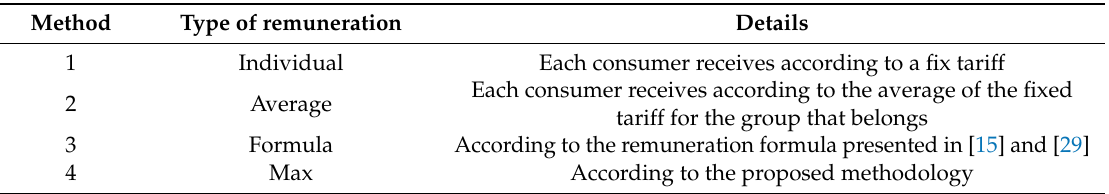
Table 8. Methods for Remuneration Comparison.